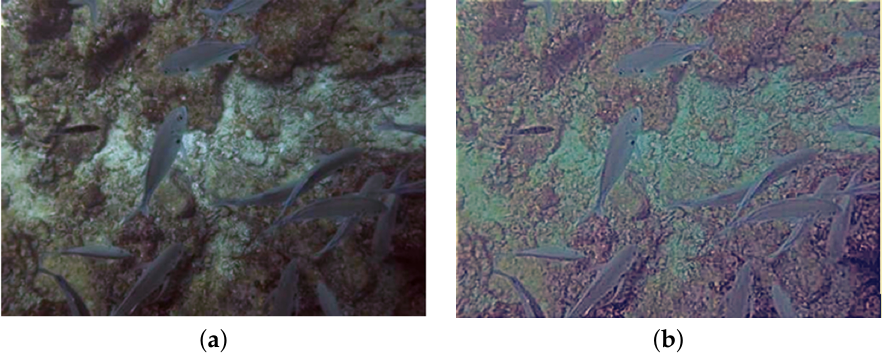
Figure 1. Comparison of the algorithms. ( a ) Color coast. ( b ) Homomorphic filtering in LAB color